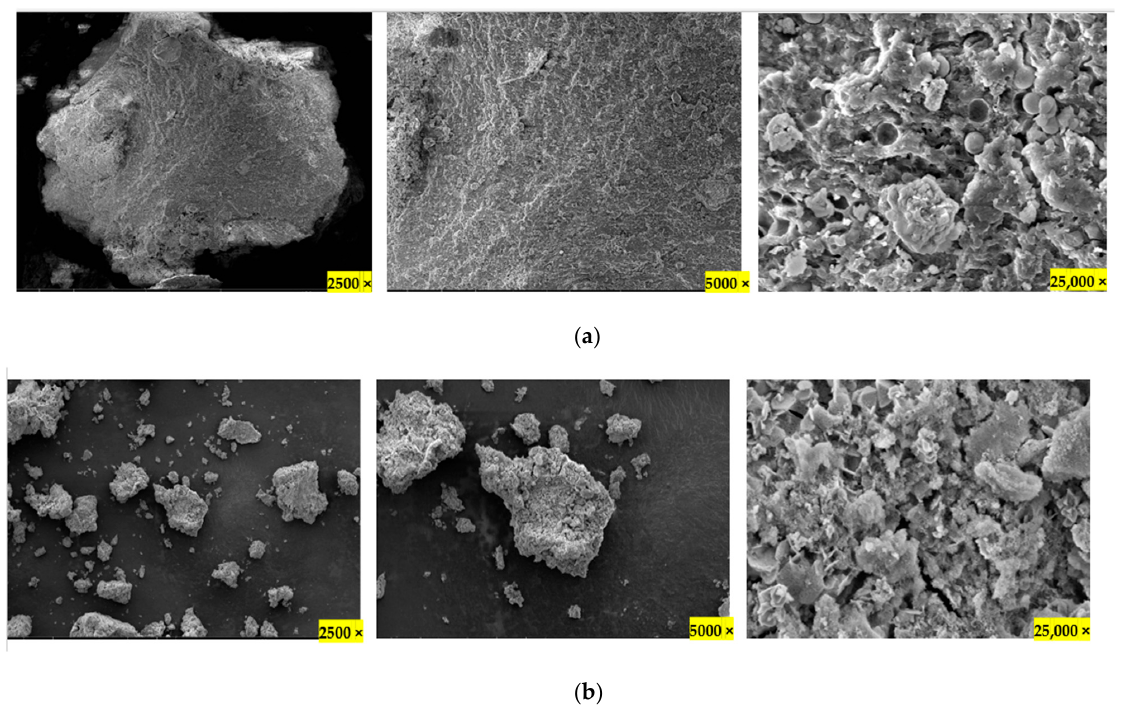
Table 1. Characteristics of biosolids before and after activation.